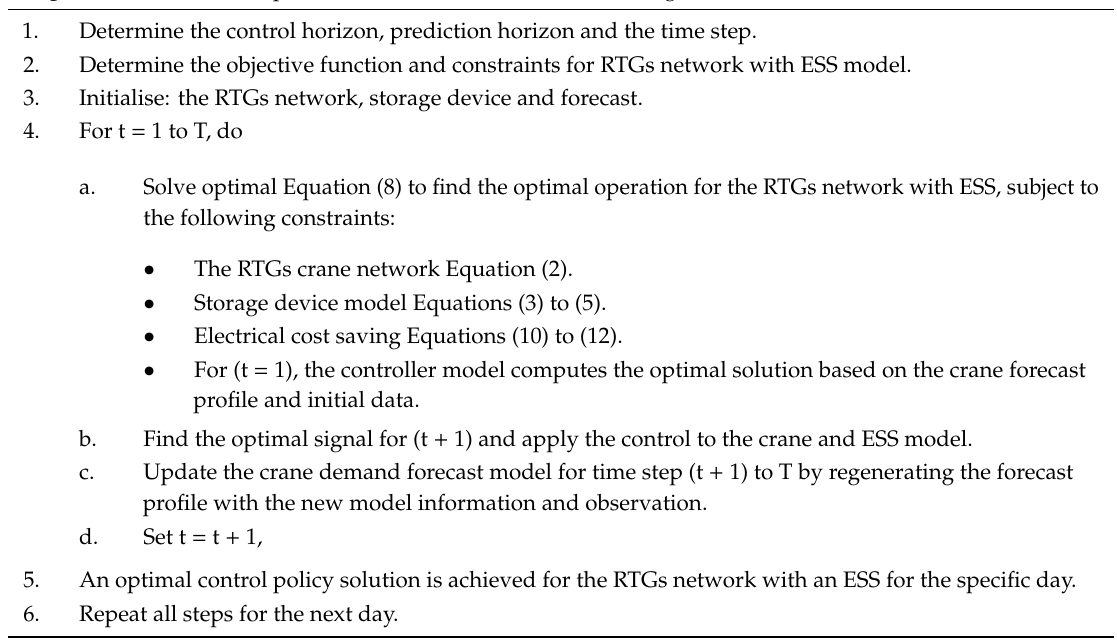
Algorithm 1: Basic concept of MPC for RTGs network with storage